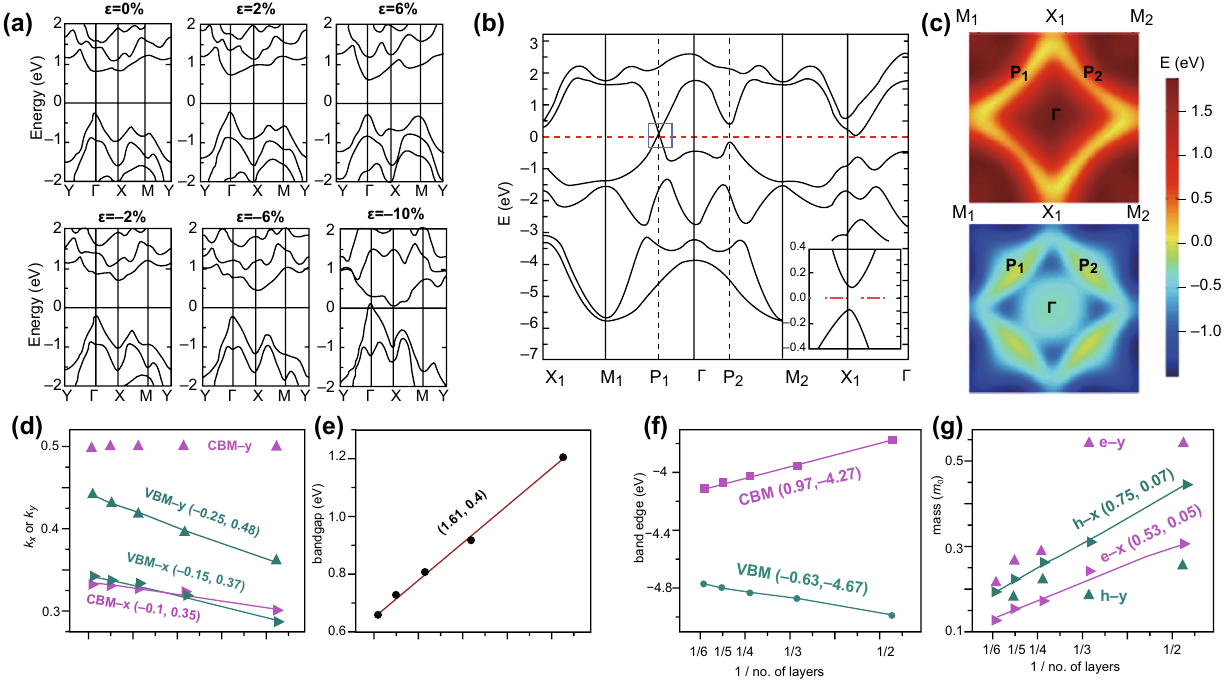
Fig. 7 a Band structures of 2D Te under different biaxial strains with SOC. Adapted with permission from [82]. Copyright 2016, arXiv. b , c Band structures and outline of the bottom CB (top of c ) and top VB band (bottom of c ) in the first Brillouin zone. Adapted with permission